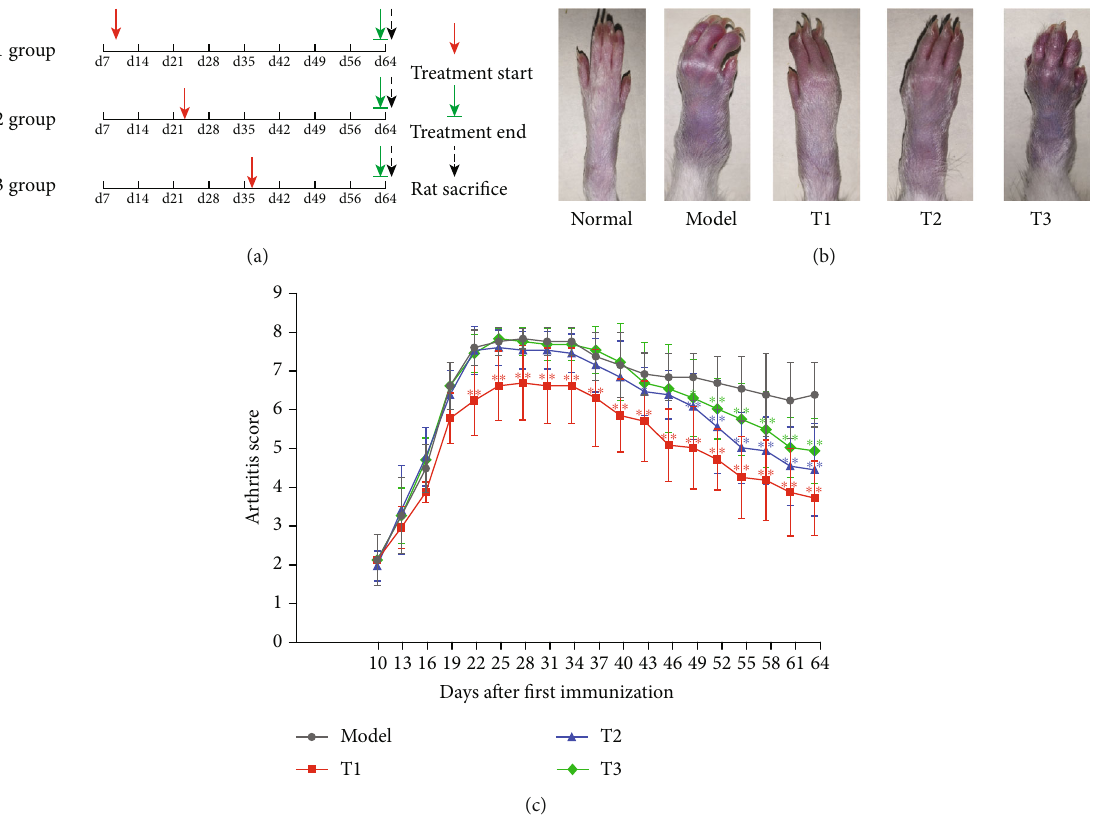
Figure 1: WB ameliorated the symptoms of CIA rats. (a) The regimen of treatment. (b) The photographs of hind paw from di ff erent groups at day 64. (c) Arthritis score. Data were mean ± SD . ∗∗ P < 0 : 01 and ∗ P < 0 : 05 compared with the model